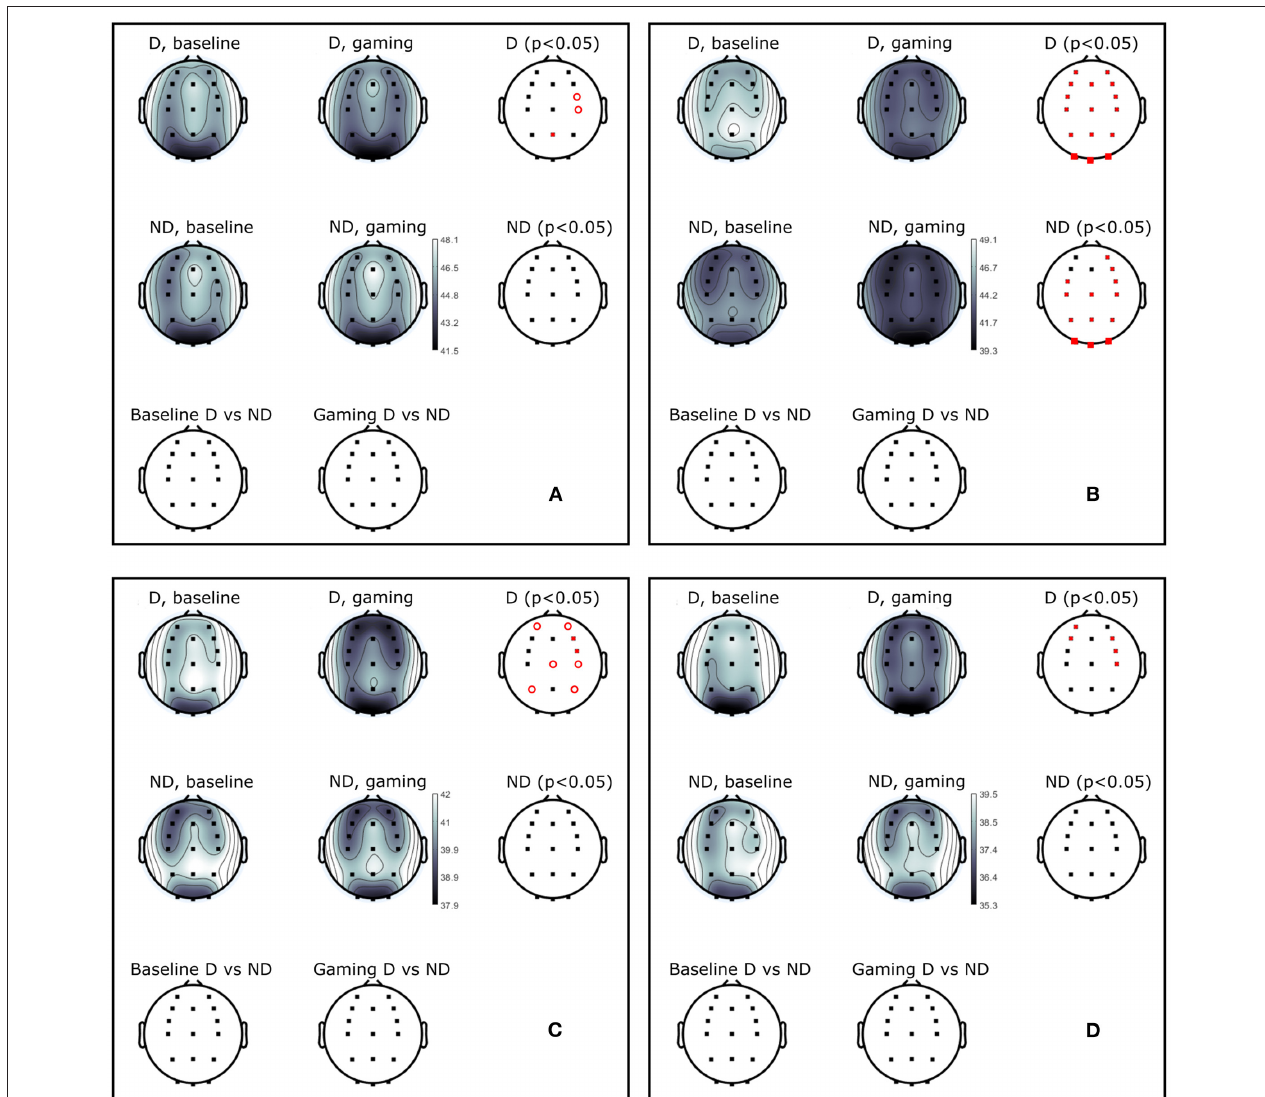
FIGURE 5 | Power (dB) during baseline and collaborative gaming for D and ND groups, in (A) theta (4–7Hz), (B) alpha (8–12Hz), (C) beta 1 (13–20Hz), and (D) beta 2 (21–30Hz) bands. Statistical difference between groups (D, ND) and conditions (baseline, game) indicated in red ( p < 0.05, open circles–before; closed circles–after FDR